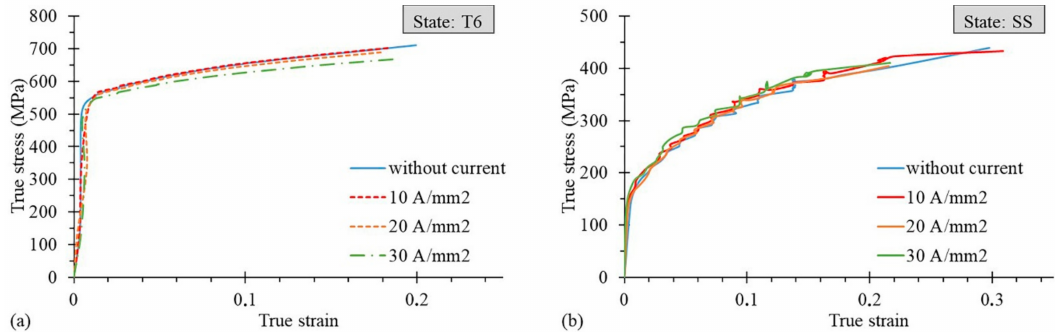
Figure 5. True stress–true strain curves for the AA7075-T6 ( a ) and SS ( b ) states at varying current density application. Figure 6a,b show the area at fracture A f values as a function of the current density.